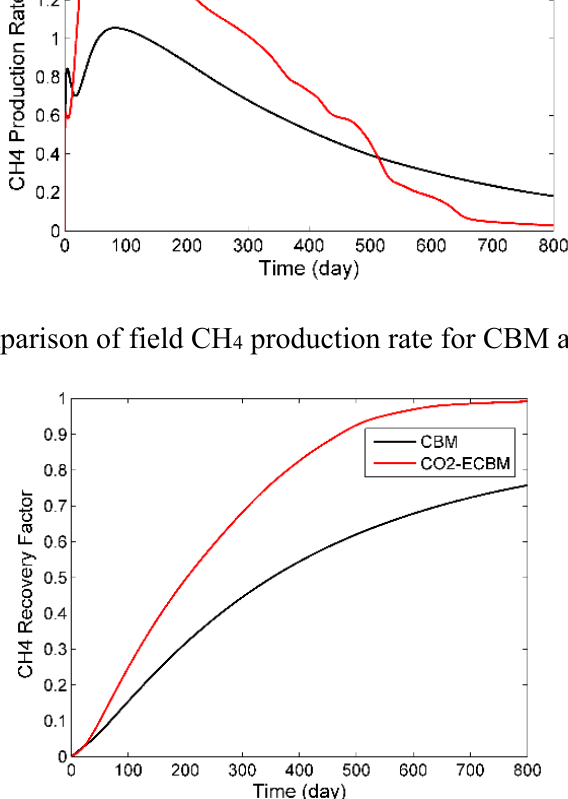
Figure 13. Comparison of CH 4 recovery factor for CBM and CO 2 -ECBM.